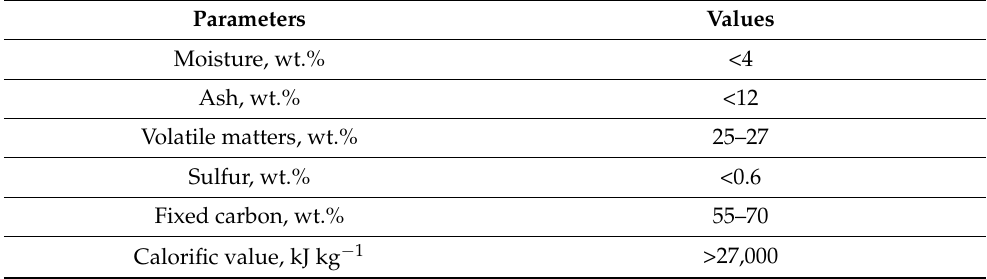
Table 7. Main requirements for coke for COREX [141,146]. Parameters Values Coke reactivity index, wt.% <35 Coke strength after reaction, wt.% >55 Volatile matters, wt.% app. 25 Ash, wt.% <15 Sulfur, wt.% Grain size,